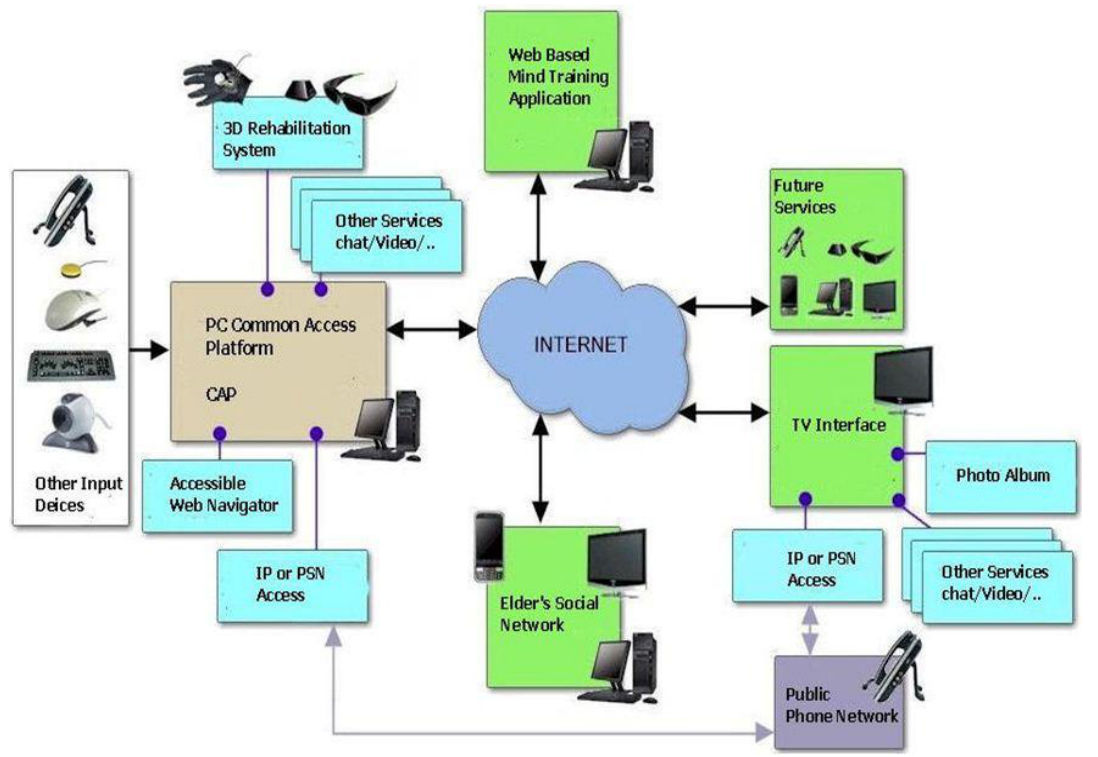
Figure 3. Naviga’s Technology